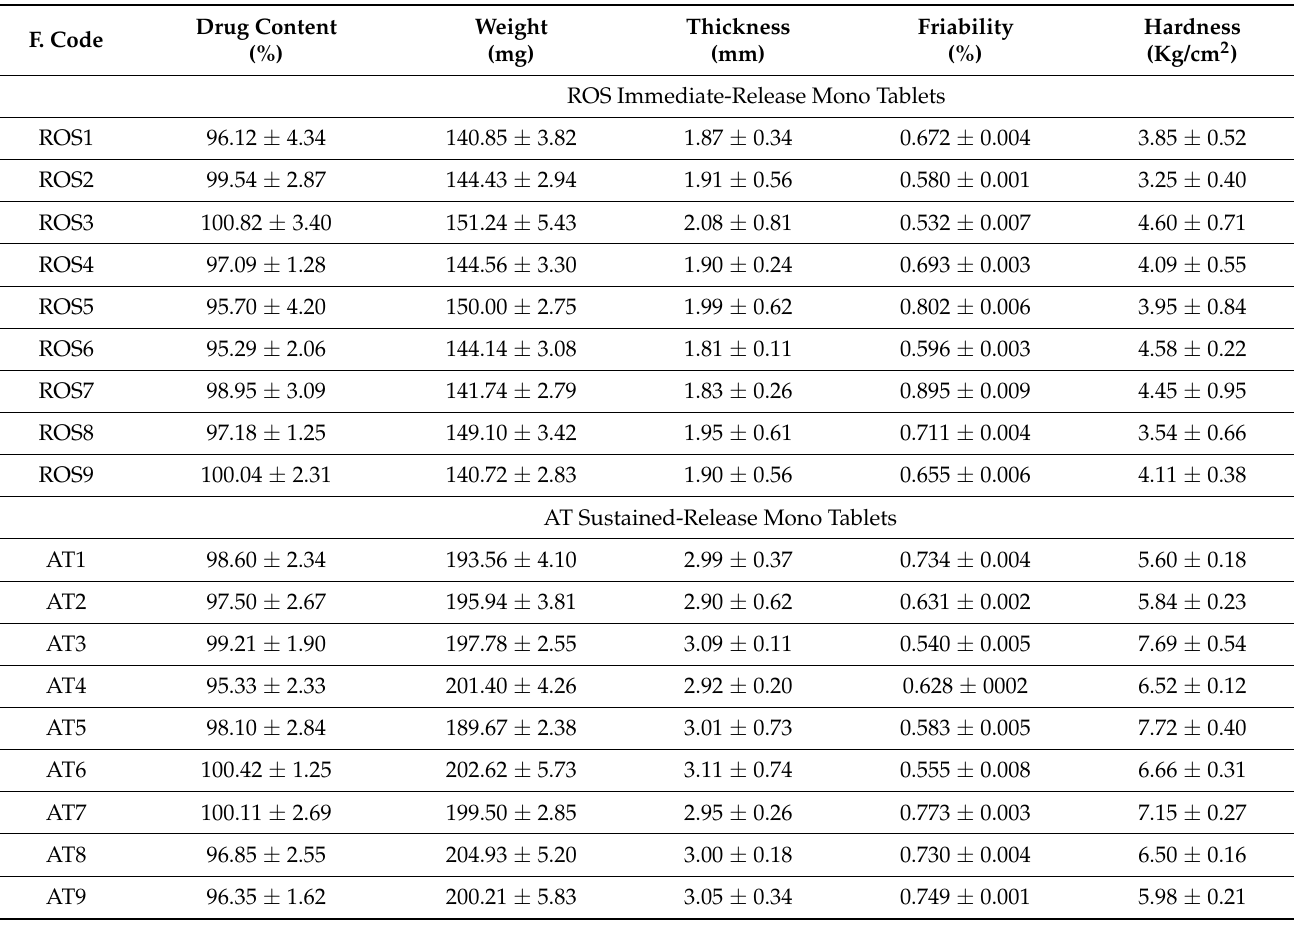
Table 6. Post-compression characterization parameters of the prepared mono